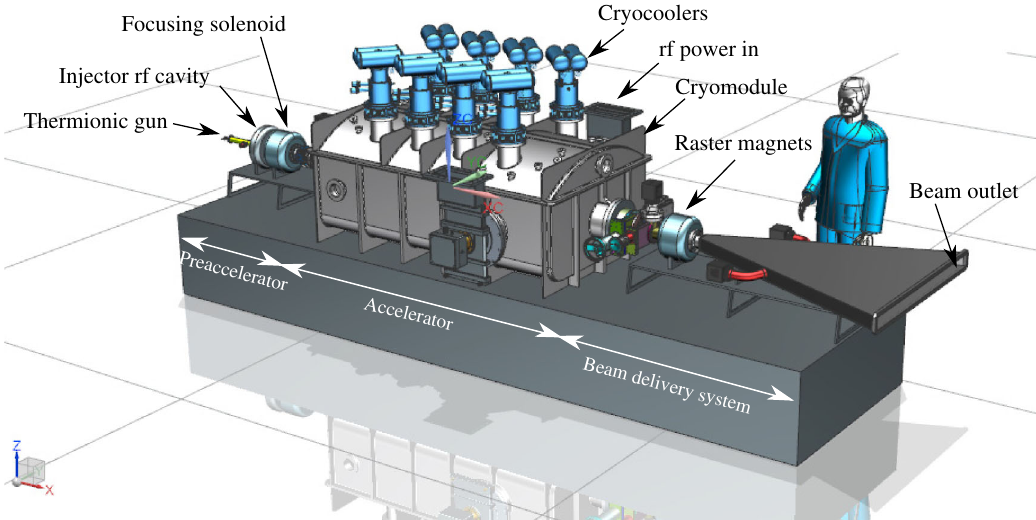
FIG. 1. e -beam accelerator components and layout. The overall size is ∼ 4 m long (end to end), ∼ 2 m wide, and ∼ 2 m tall.